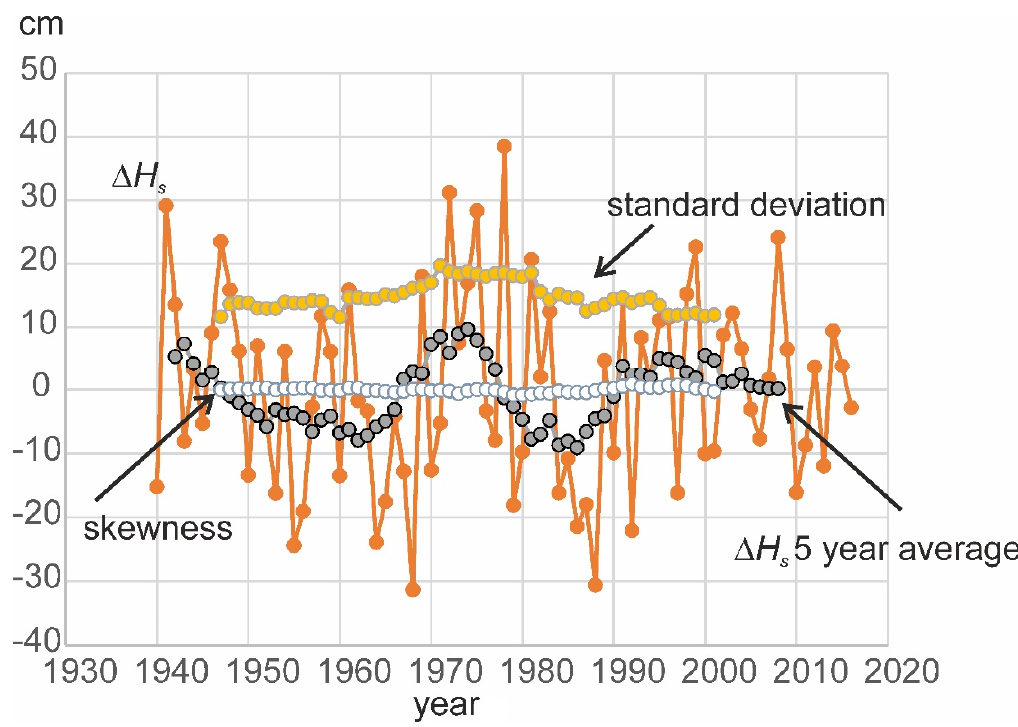
Figure 28. Characteristics of de-trended sequences of snow pack depth at the Novy Port station. See the text for the details.